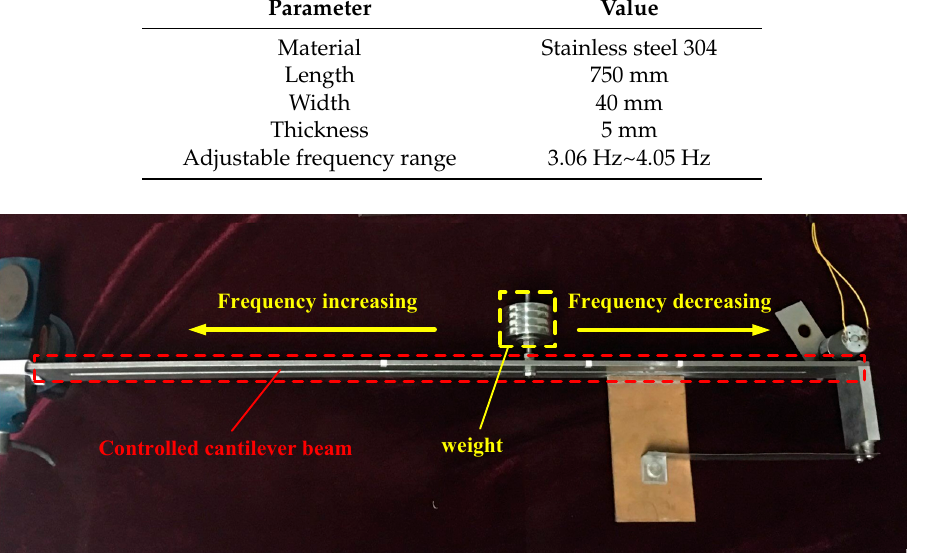
Figure 3. A moveable lumped weight installed on the cantilever beam.